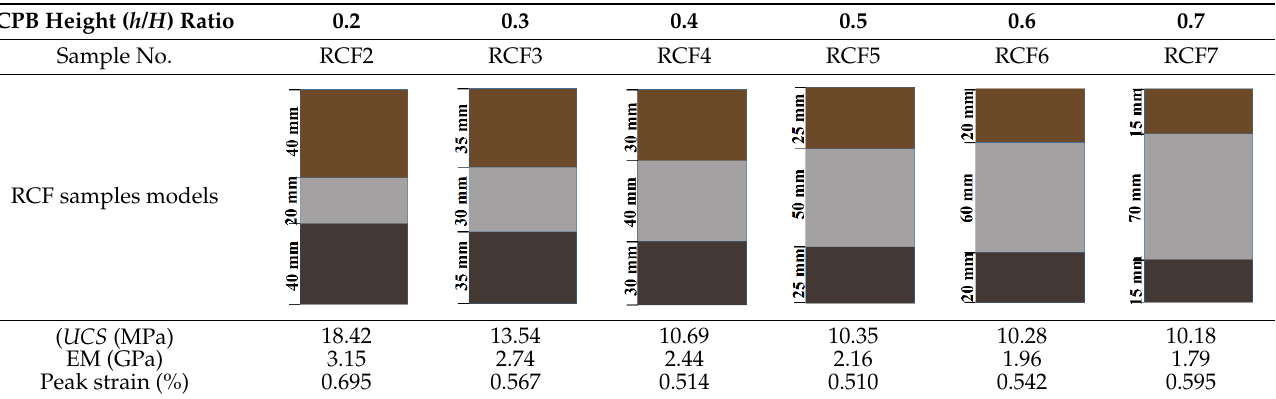
Table 3. Mechanical parameters and number of RCF samples.